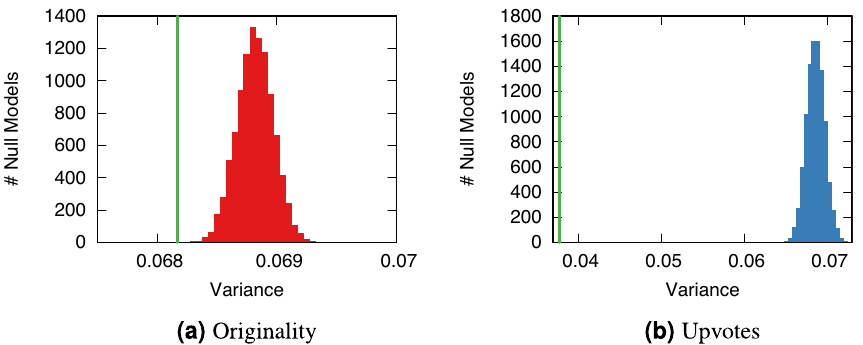
Figure 2. The network variance of originality and upvotes. The observed value of network variance is located at the green vertical bar. The histograms report the value distribution from the null models. The figure shows how many null models (y axis) recorded a given network variance value (x axis) for ( a ) originality O T (red), and ( b ) upvotes